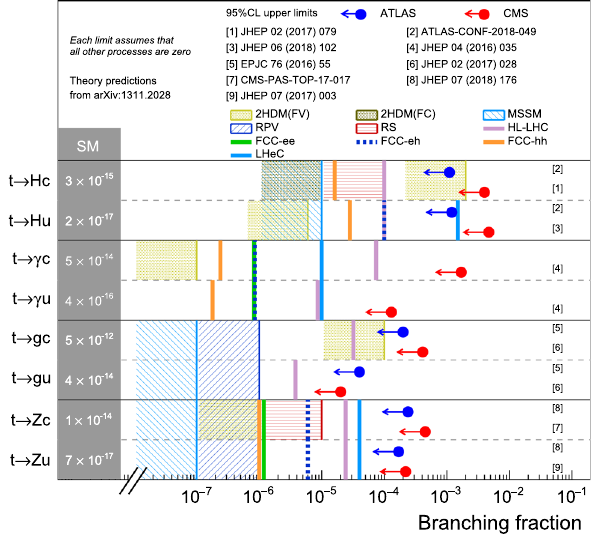
Fig. 6.3 FCC-ee measurement uncertainties in the left and right cou- pling of the top to the Z (left) and to the photon (right) displayed as an ellipse. In the left plot the SM value at (0,0) is compared to predicted